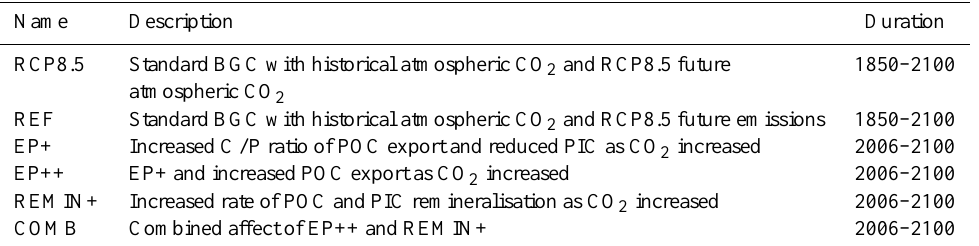
Table 2. Summary of the ocean BGC experiments presented in this study. In all simulations, both the climate and the carbon components experience the impact of rising atmospheric CO 2 . The RCP8.5 simulation uses the prescribed atmospheric CO 2 as provided by the CMIP5 for this scenario, while the others scenarios use the RCP8.5 emissions and the ESM determines the CO 2 concentration. In the REF and RCP8.5 simulations, the formulation of the ocean BGC is not impacted by OA, while in the other simulations selected processes are modified to address the potential OA impacts. The REF simulation starts in 1850 using historical atmospheric CO 2 (identical to RCP8.5) and switches to the RCP8.5 future emissions scenario at the start of 2006. The four other simulations (EP+, EP++, REMIN+ and COMB) start from the REF simulation at the end of 2005 and go until 2100 using the RCP8.5 future emissions. Please refer to the text for a description of how the BGC cycle is modified in the EP+, EP++, REMIN+ and COMB